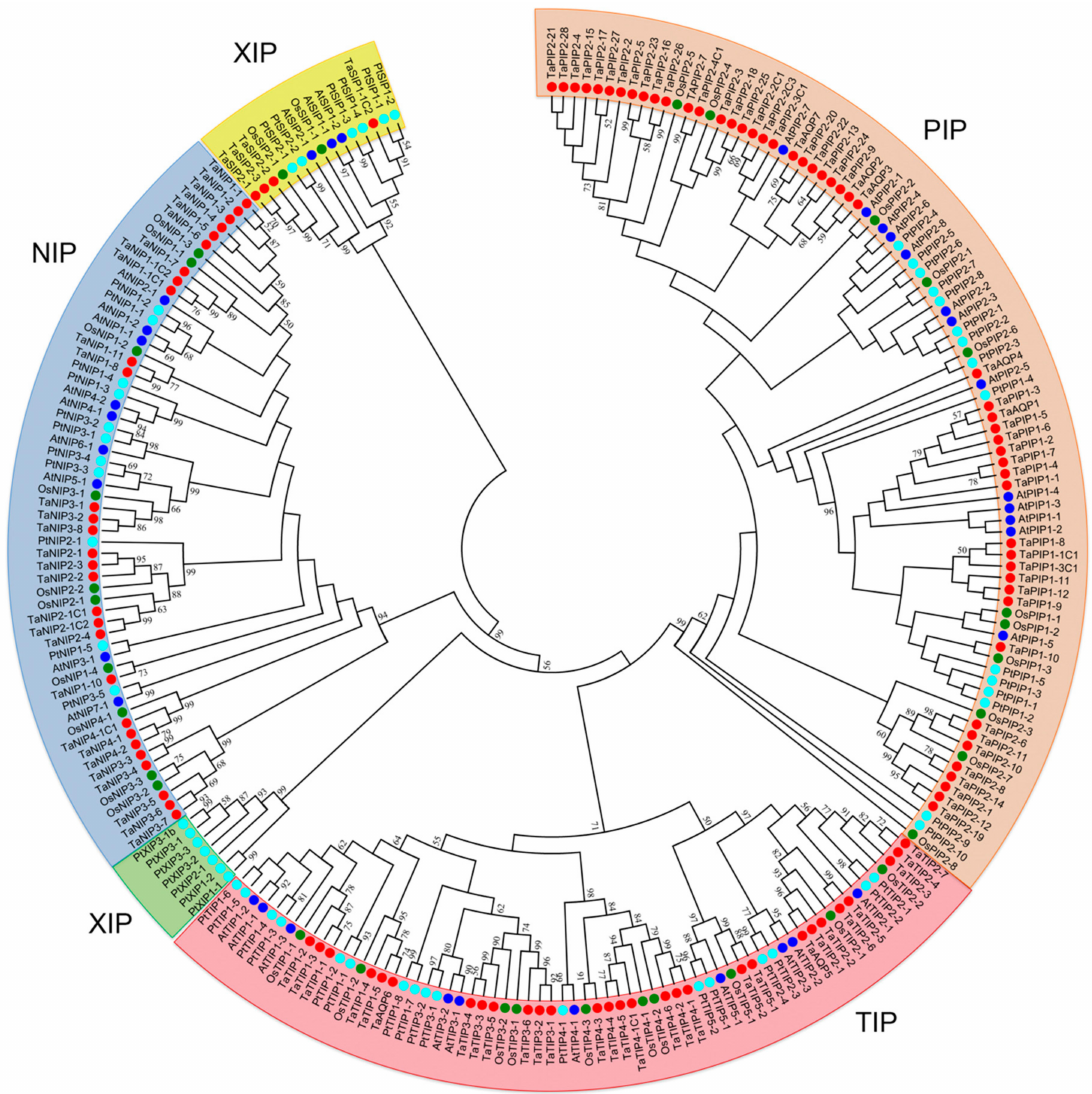
Figure 1. Phylogenetic tree for Aquaporins (AQP) identified in Triticum aestivum , Arabidopsis thaliana , Populus trichocarpa and Oryza sativa . Five protein families (PIP, NIP, TIP, XIP and NIP) were identified. In red circles, 113 AQPs from wheat; in light-blue, 56 from P. trichocarpa ; in dark-blue, 36 from A. thaliana ; in green, 33 from O. sativa (Table